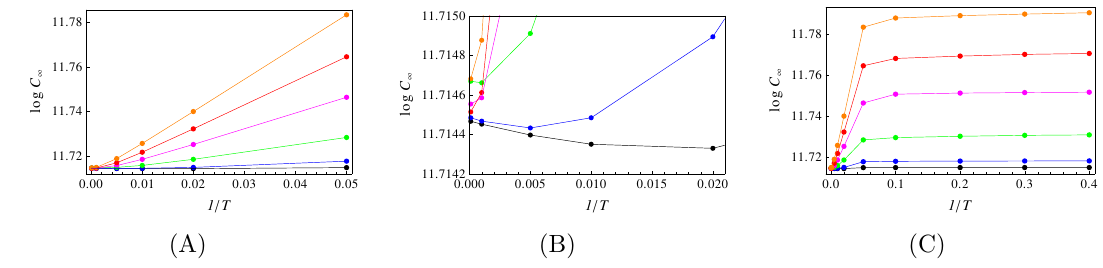
Figure 6. (A) The saturated kinematic OTOC value C ∞ for a range of inverse temperatures β = 10 − 4 , 10 − 3 , 5 × 10 − 3 , 0 . 01 , 0 . 02 , 0 . 05 and a range of perturbation strengths (cid:15) = 1 , 2 , 5 , 10 , 15 , 20 (black, blue, green, magenta, red, orange). Here we see the scaling C ∞ ∝ exp( c/T ) , with c growing with (cid:15) . In the (B) panel we zoom in the high-temperature region, to show that for (cid:15) ≤ 5 there is also the other regime where C ∞ grows with T . Since the number of points in this interval is small it is not easy to judge the form of T -dependence. In (C) we focus on the opposite regime, at very low temperature, showing that C ∞ saturates as T → 0 . This is again in accordance with the β → ∞ limit of Z (2 β ) /Z ( β ) . The system is truncated to N = 144 levels.